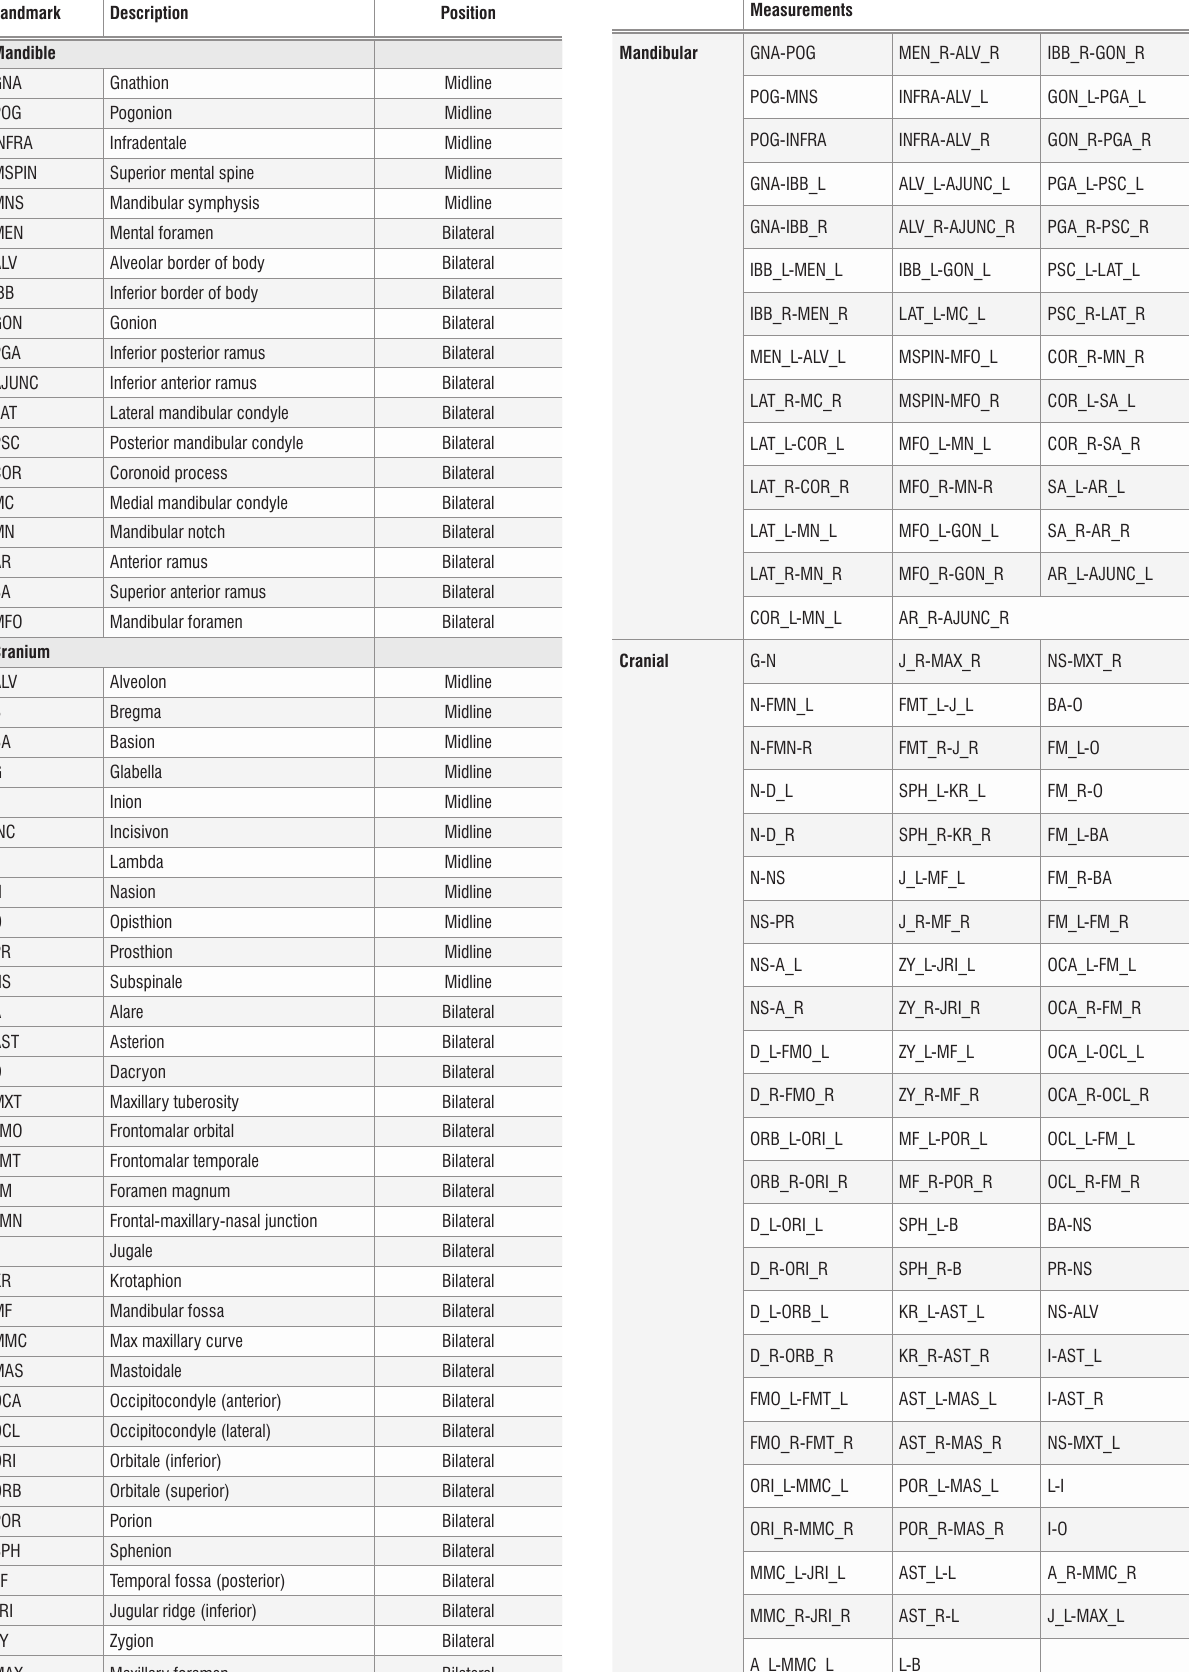
Table 1: Craniomandibular landmarks extracted from three-dimen sional scans Landmark